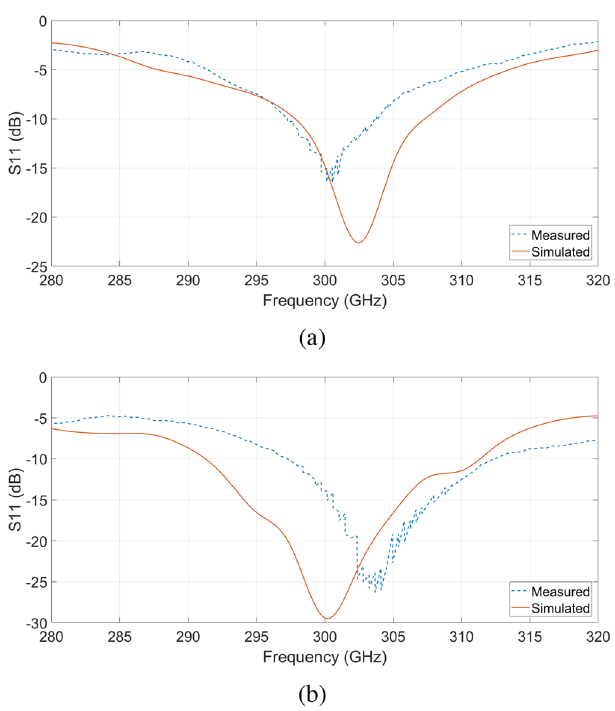
Figure 7. Measured and simulated reflection coefficients of the non-MM-loaded and MM-loaded